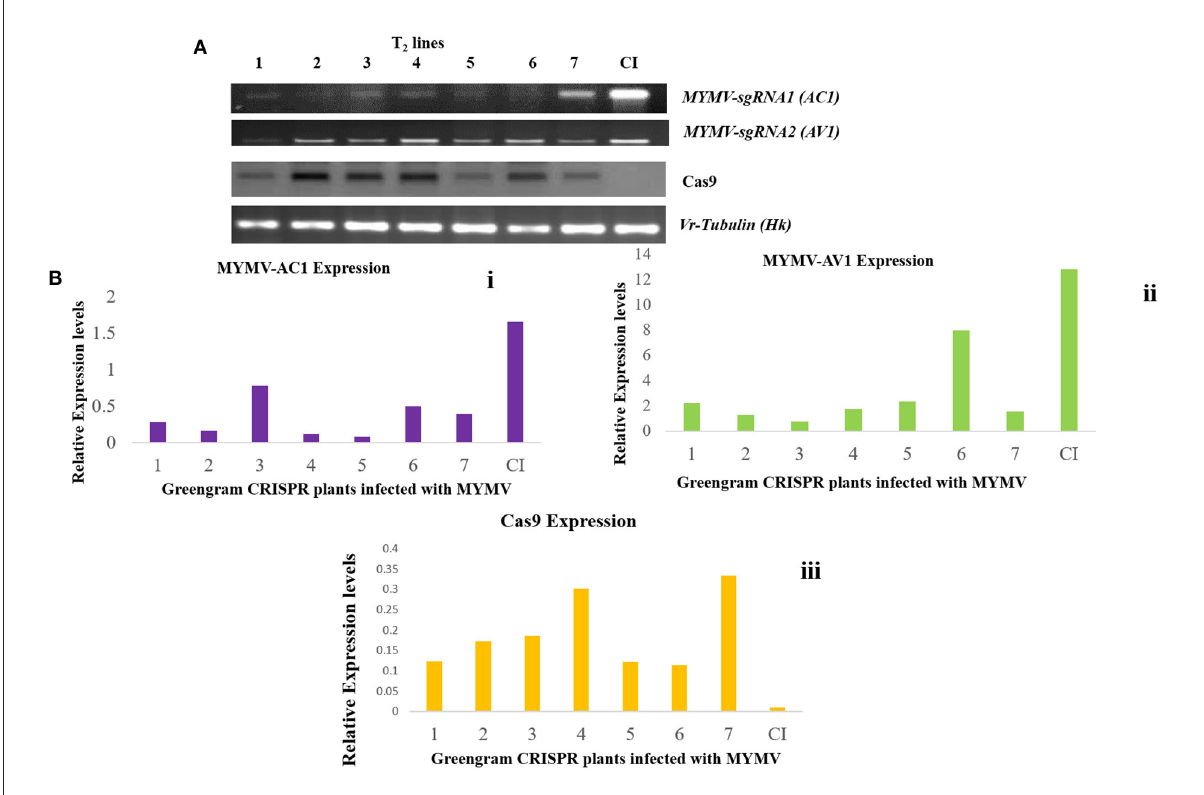
FIGURE7 (A) Expression of AC1, AV1, and Cas9 genes in transgenic greengram plants- quantitative PCR showing the transcript expression pattern of MYMV-sgRNA1 (AC1), MYMVsgRNA2 (AV1), Cas9, and Vr Tubulin as reference gene in control and transgenic lines which were infected with MYMV via Agroinfiltration CI: MYMV infected control, 1–7 transgenic greengram plants challenged with MYMV clone. (B) Relative expression of AC1, AV1, and Cas9 genes in transformed and untransformed plants: viral transcript analysis: i. Accumulation of viral transcript was minimal